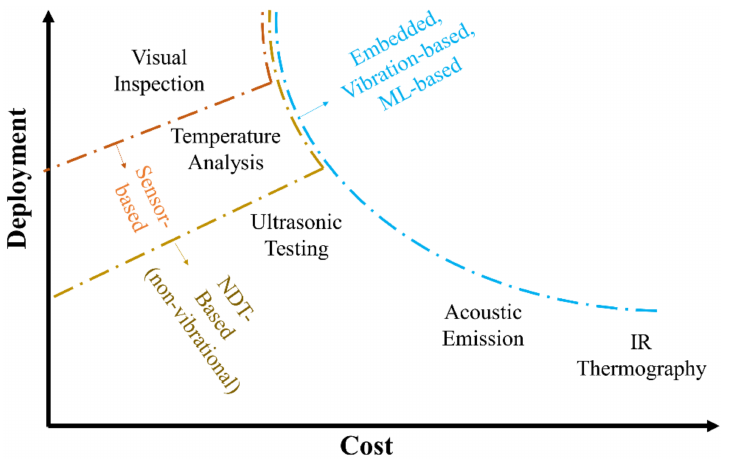
Figure 13. Qualitative distribution of costs and deployment levels of different NDTs. Based on data from Refs.